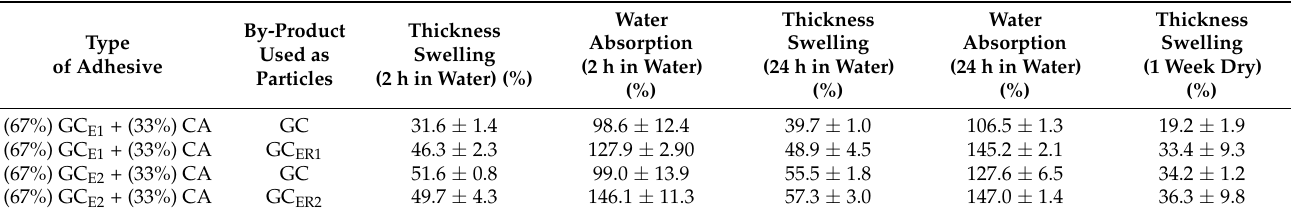
Table 10. Results for grape cane particleboards bonded with GC E and citric acid.